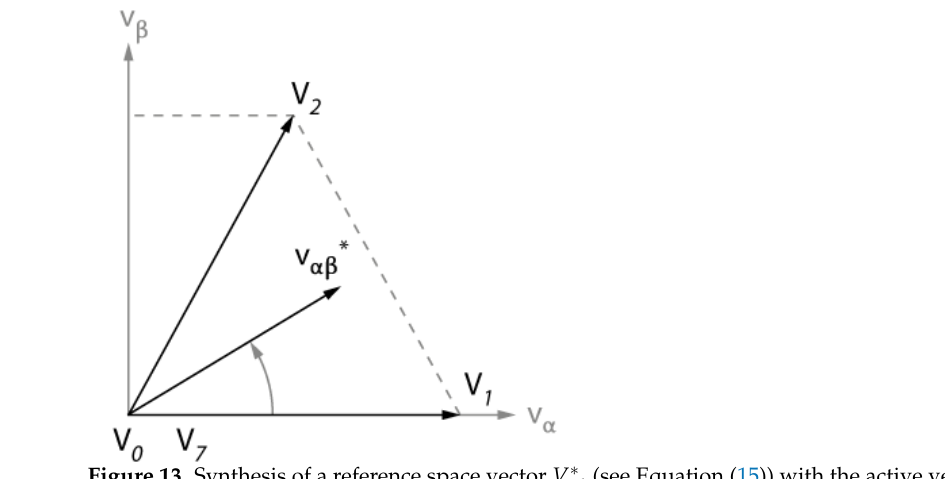
(see Equation (15)) with the active vectors V 1 and αβ